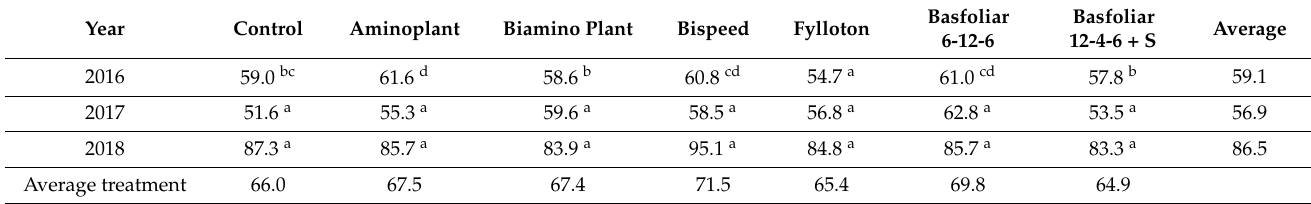
Table 1. The height of M.9 rootstock stoolings depending on the tested treatments